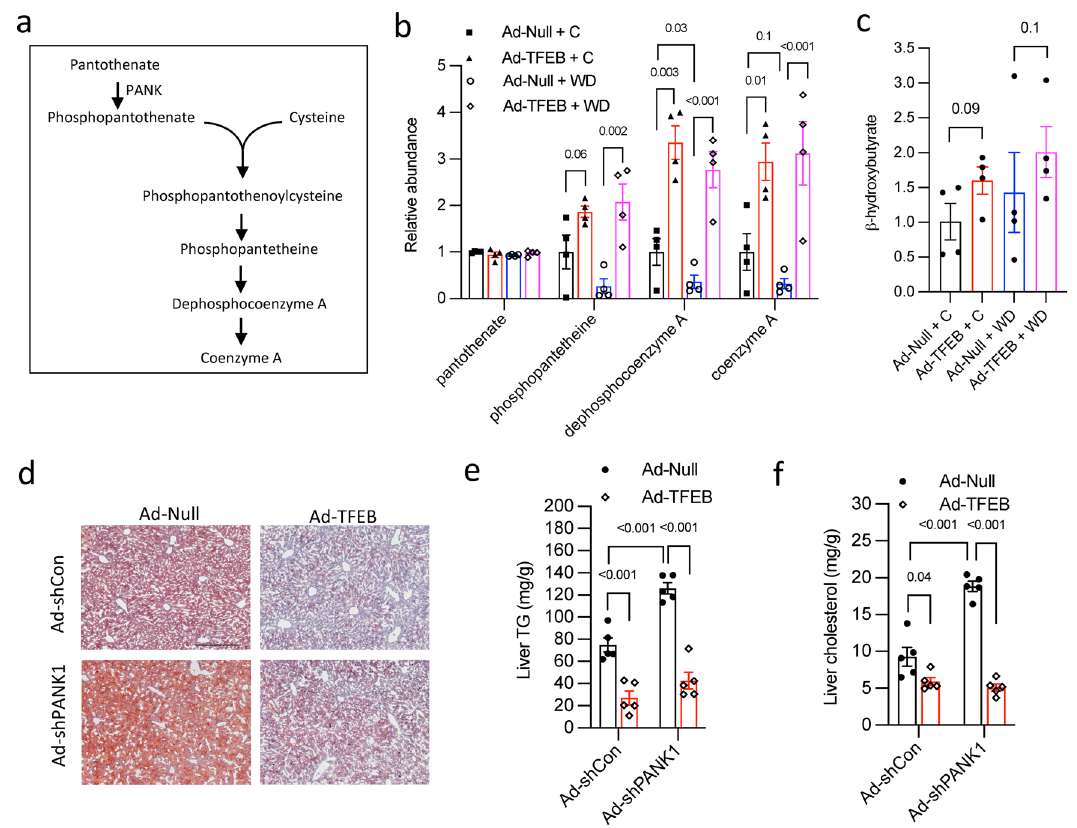
Fig. 4 | TFEB stimulates hepatic CoA synthesis to support fatty acid metabo- lism.a IllustrationoftheCoenzymeA(CoA)synthesispathway.PANK:patothenate kinase. b , c Male10 weeksold C57BL/6J mice wereintravenously injected withAd- Null or Ad-TFEB at 5 × 10 8 pfu/mouse. One week later, mice were fed chow (C) or Western diet (WD) for one additional week. Mice were fasted for 6h and eutha- nized.Relativeabundanceoflivermetabolitesareshownwithcontrolarbitrarilyset as 1 ( n =4). d , e , f Adenovirus injected male 10 weeks old C57BL/6J mice (Ad-Null and Ad-TFEBat5x10 8 pfu/mouse and Ad-shCon(Ad-scramble)andAd-shPANK1at